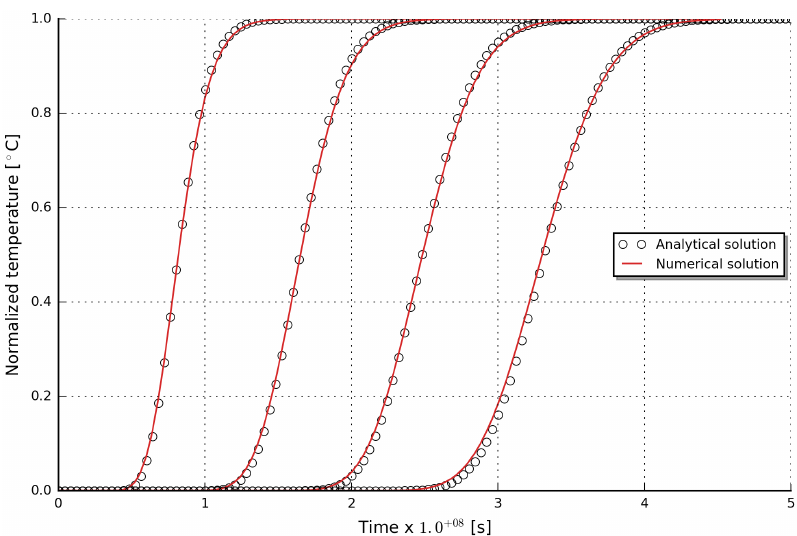
Figure 4. Comparison of numerical results (red curves) and analytical solutions (black circles) for heat transport in a fracture. The figure shows the temperature evolution at different positions along the fracture as a function of time.